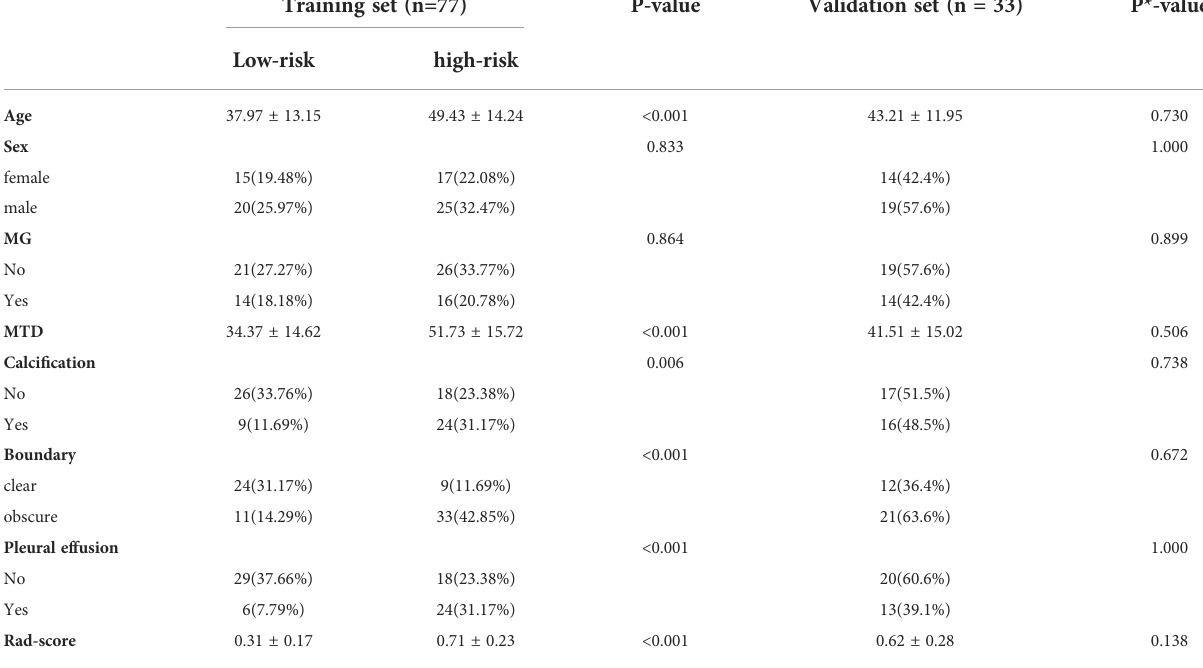
TABLE 1 Demographic characteristics in the training and validation